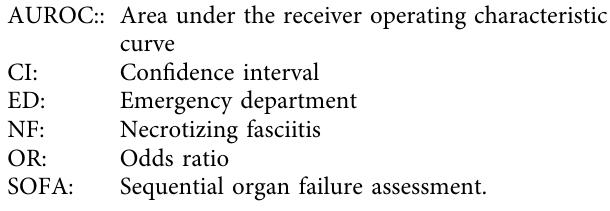
Data are available on request.